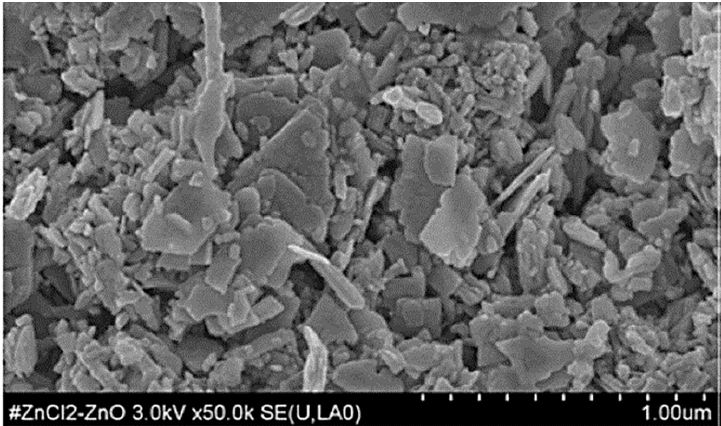
Figure 8. Field emission scanning electron microcopy (FE-SEM) image of ZnO plates. Reproduced with permission from [179]. Copyright American Chemical Society, 2014.